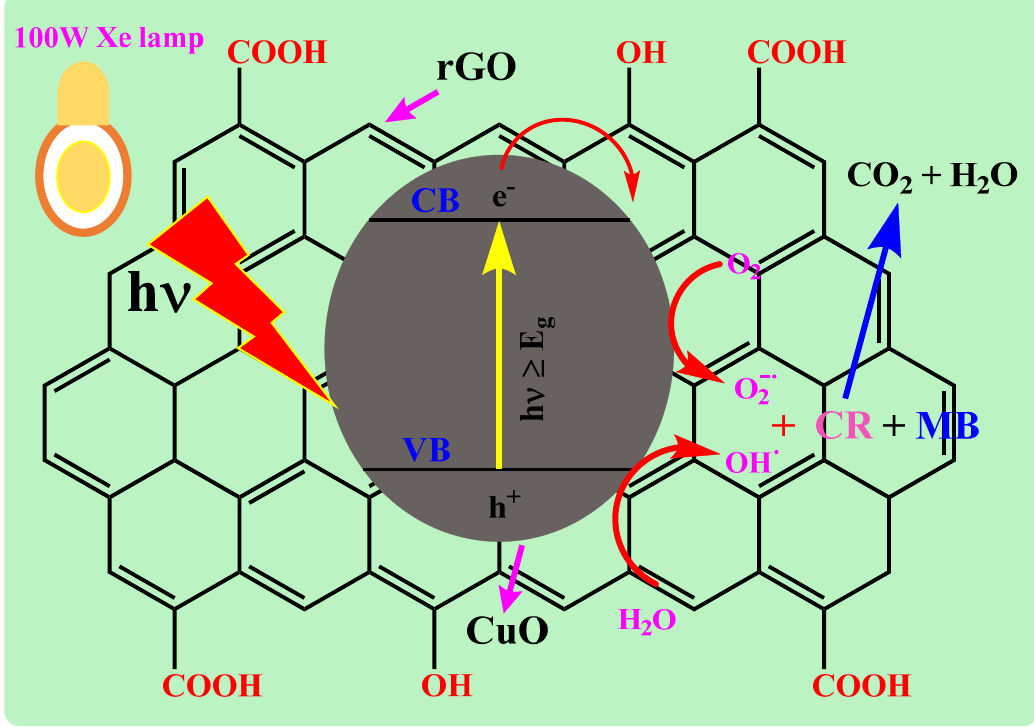
Figure 8. Formation of charge carriers and their transfer mechanism during the visible light assisted degradation of MB and CR dyes using rGO-CuO nanocomposites.